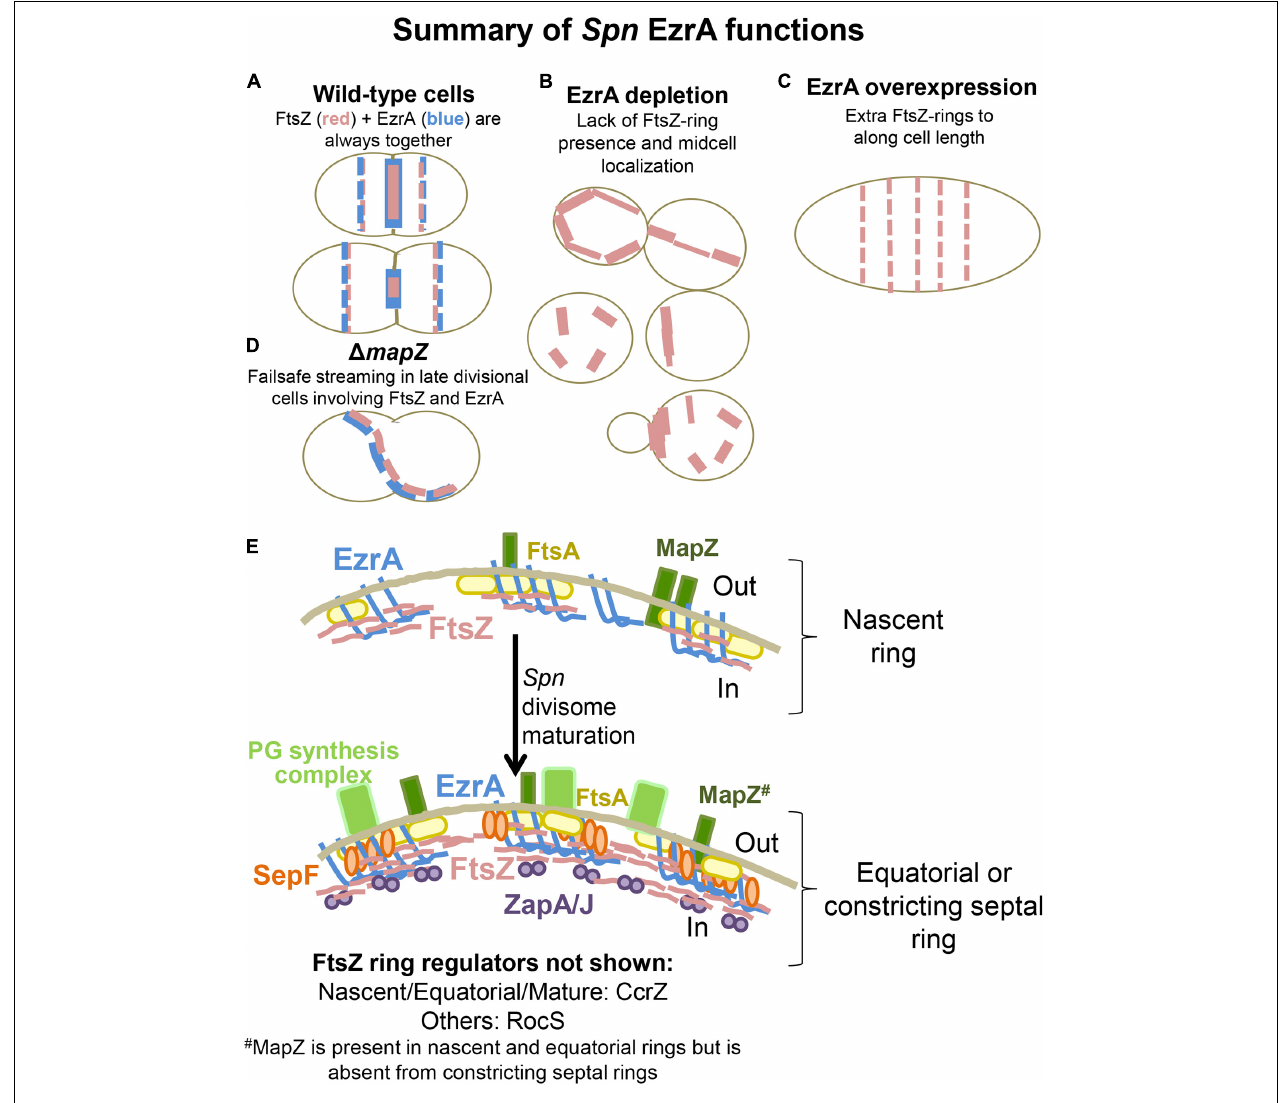
FIGURE 12 | Schematic drawings indicating EzrA as a positive Z-ring regulator in Spn, whereas EzrA, SepF, ZapA, and ZapJ form a multi-layered network of proteins that synergistically regulate the FtsZ-ring and cell division in Spn during divisome maturation. (A–D) Phenotypes of cell shape and FtsZ localizations observed in (A) WT, (B) EzrA depletion (C) EzrA overexpression and (D) (cid:49) mapZ. (E) Summary diagram depicting the spatial localization patterns of FtsZ, EzrA, ZapA/J, SepF, and PG synthesis complexes during divisome maturation in Spn. EzrA/FtsZ/FtsA and MapZ form early arriving Z-ring regulators while ZapA/J and SepF are late arriving Z-ring regulators. RocS arrives early but is not divisome associated while CcrZ connects early Z-ring formation with DNA replication. EzrA and FtsA are membrane anchors for FtsZ filaments. SepF localizes with FtsZ, while ZapA, and by extension ZapJ, are on the inside of the